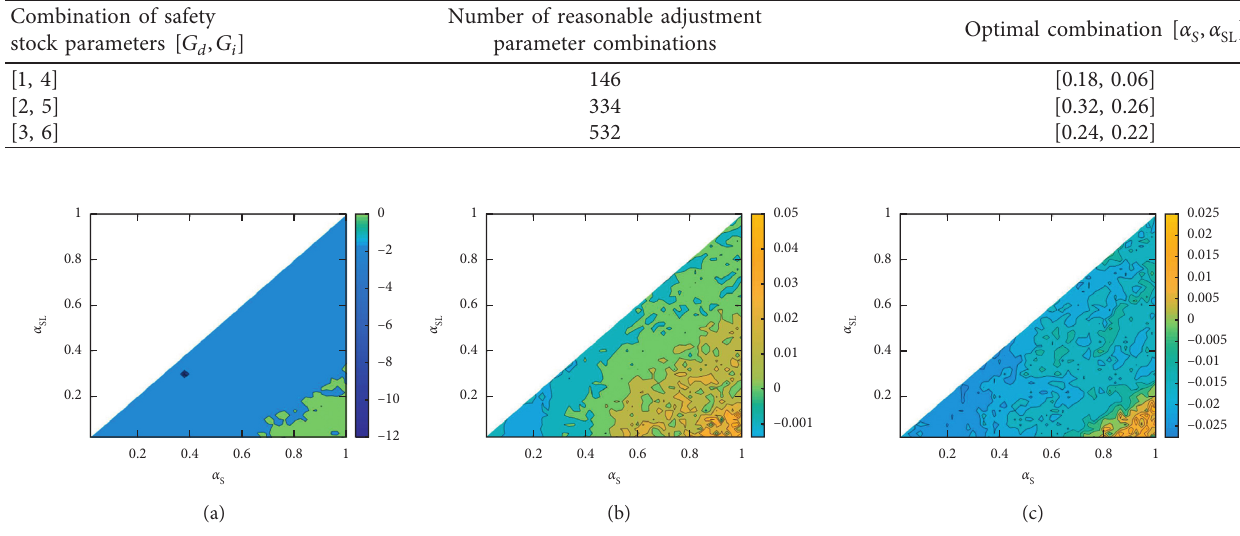
Figure 14: LLE diagram of supply chain nodes under the scenario of random demand obeying normal distribution from local perspective � 4. (a) The retailer’s LLE chart. (b) The LLE chart of the distribution center. (c) The LLE chart of the combined system when G d � 1 and G 1 from the decision perspective.